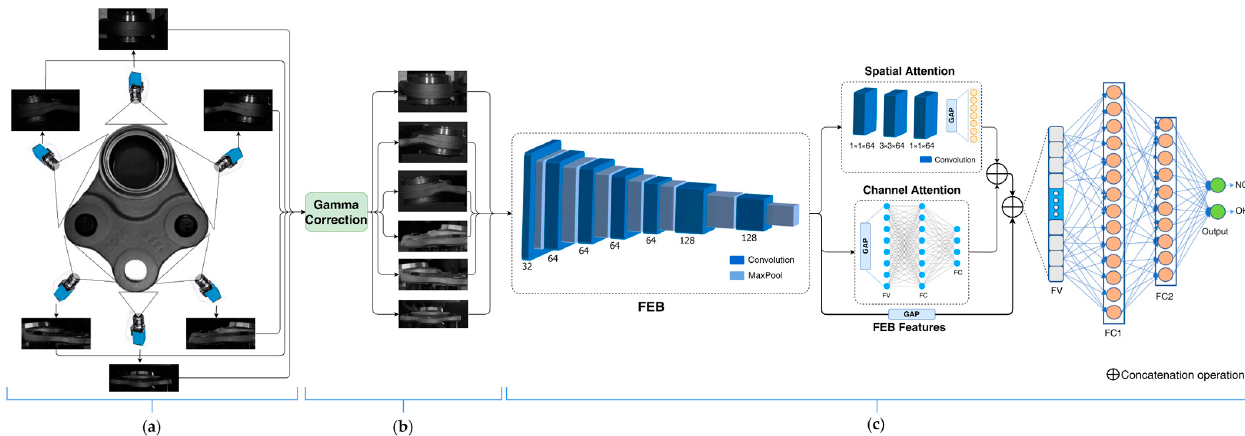
Figure 1. An overview of the proposed defect inspection framework. ( a ) Inspection surface acquisition, ( b ) image preprocessing, ( c ) proposed CNN model with the spatial and channel attention (SCA). FEB—feature extraction block. GAP—global average pooling, FV—feature vector, FC—fully connected layer.